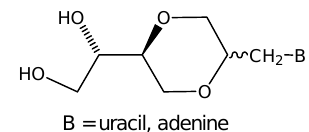
Figure 1. A representative structure of the 1,4-dioxane homo- N -nucleoside analogs.